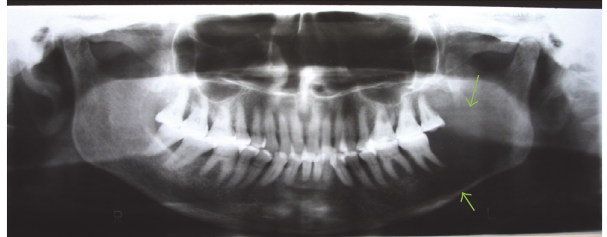
Figure 2: Preoperative orthopantomogram (arrow) showing diffuse irregular multilocular radiolucency in the left side of the lower jaw extending from parasymphysis region to the ramus of the